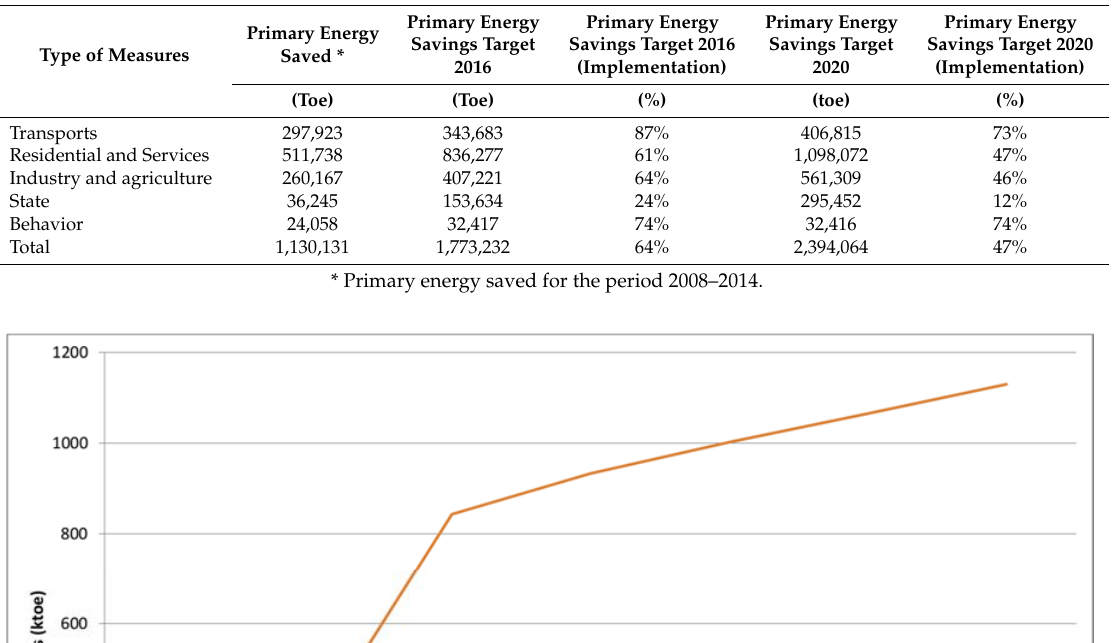
Table 2. Degrees of implementation of the measures within the NEEAP for 2016 and 2020 [9].